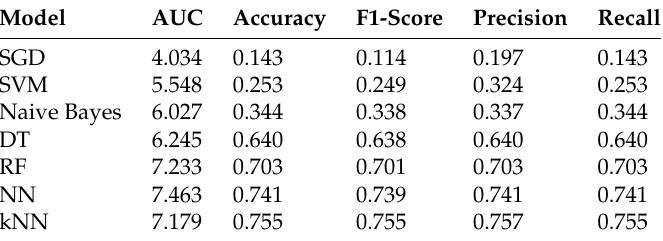
Table 12. Classification results using processed accelerometer, gyroscope, and magnetometer